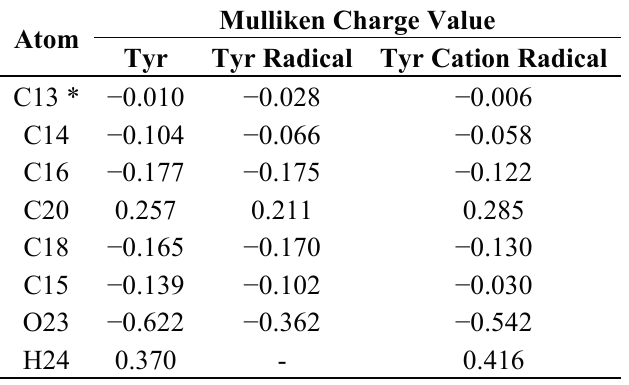
Table 3. The Mulliken charge distribution in Tyr and corresponding radical and cation radical.